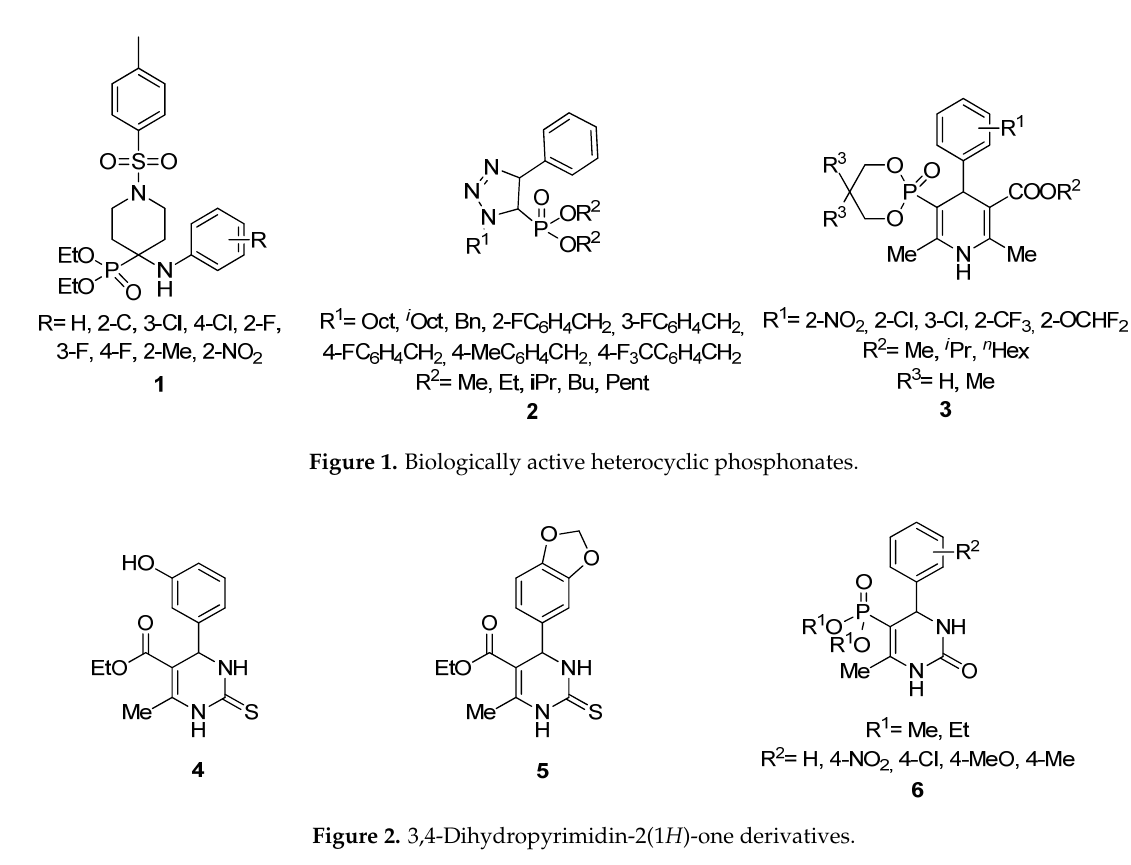
Figure 2. 3,4 ‐ Dihydropyrimidin ‐ 2(1 H ) ‐ one derivatives.